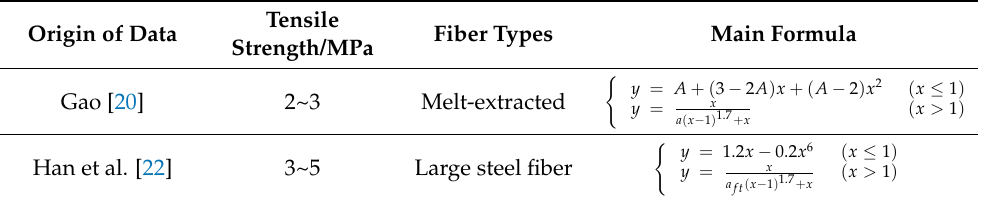
Table 1. Theoretical stress–strain models of SFRC under tension in literature.